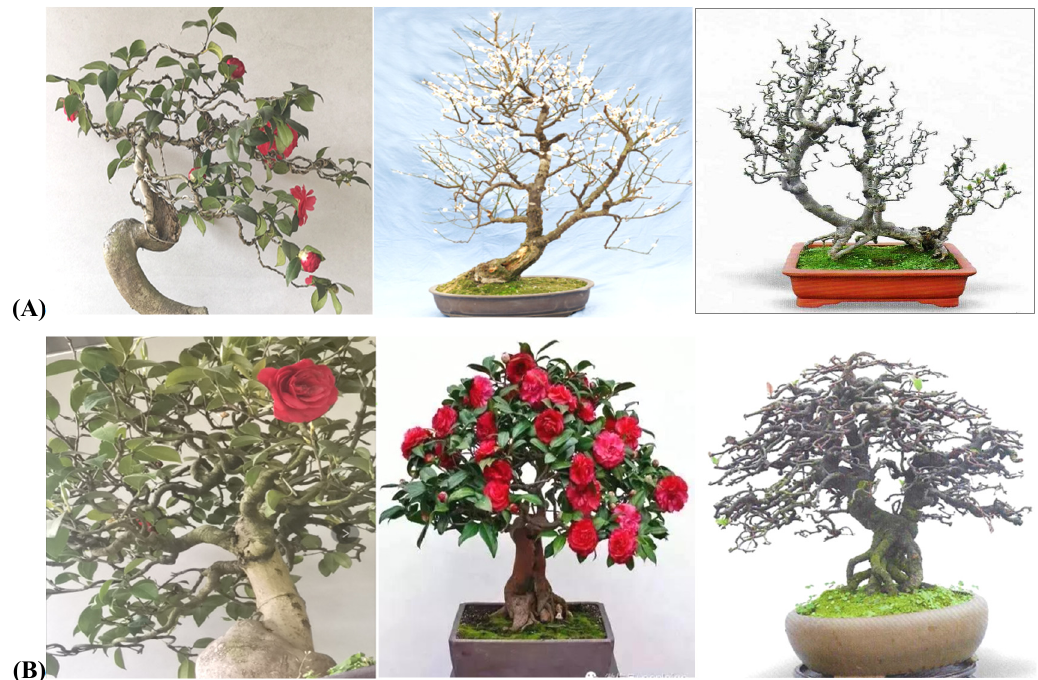
Figure 7. The small ( A ) and large ( B ) rolling-branch styles.